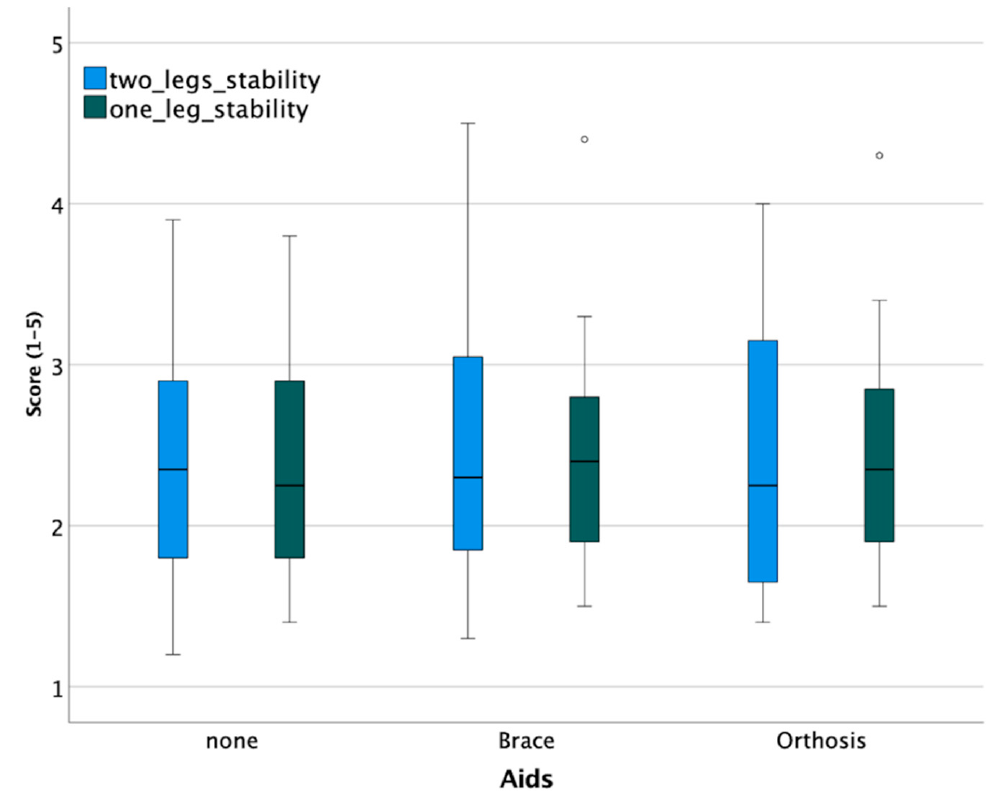
Figure 4. Stability tests show no clinically relevant difference between devices ( ◦ are outliers). A statistically significant difference was not observed between groups (Table 2). Table 2. Test statistics for between-group differences. SQUARE Chi 2 /F * Sig. SUM